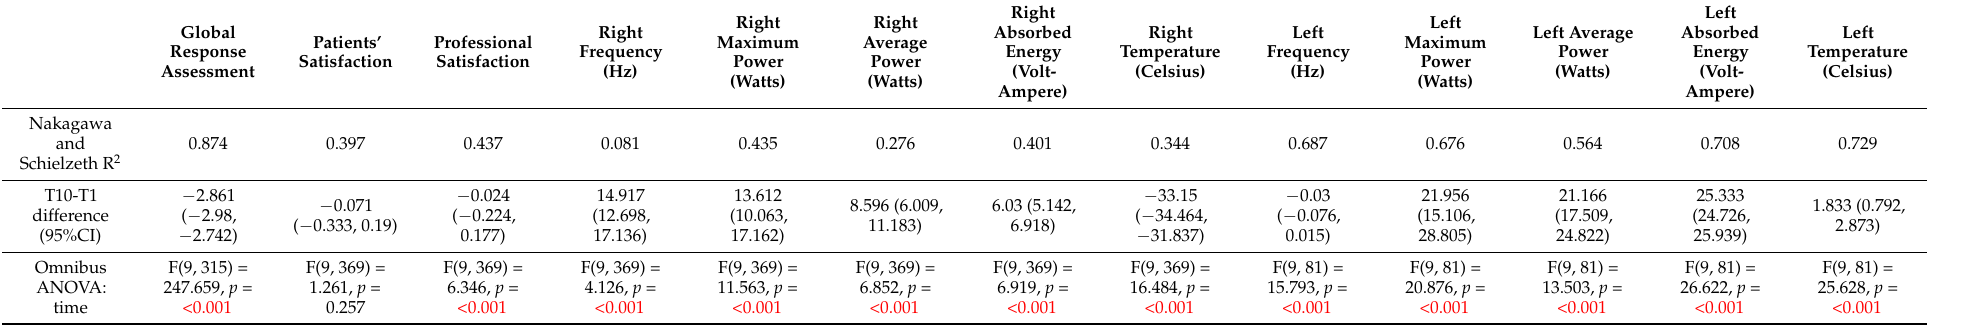
Table 2. Subjective perception and radiofrequency parameters: model